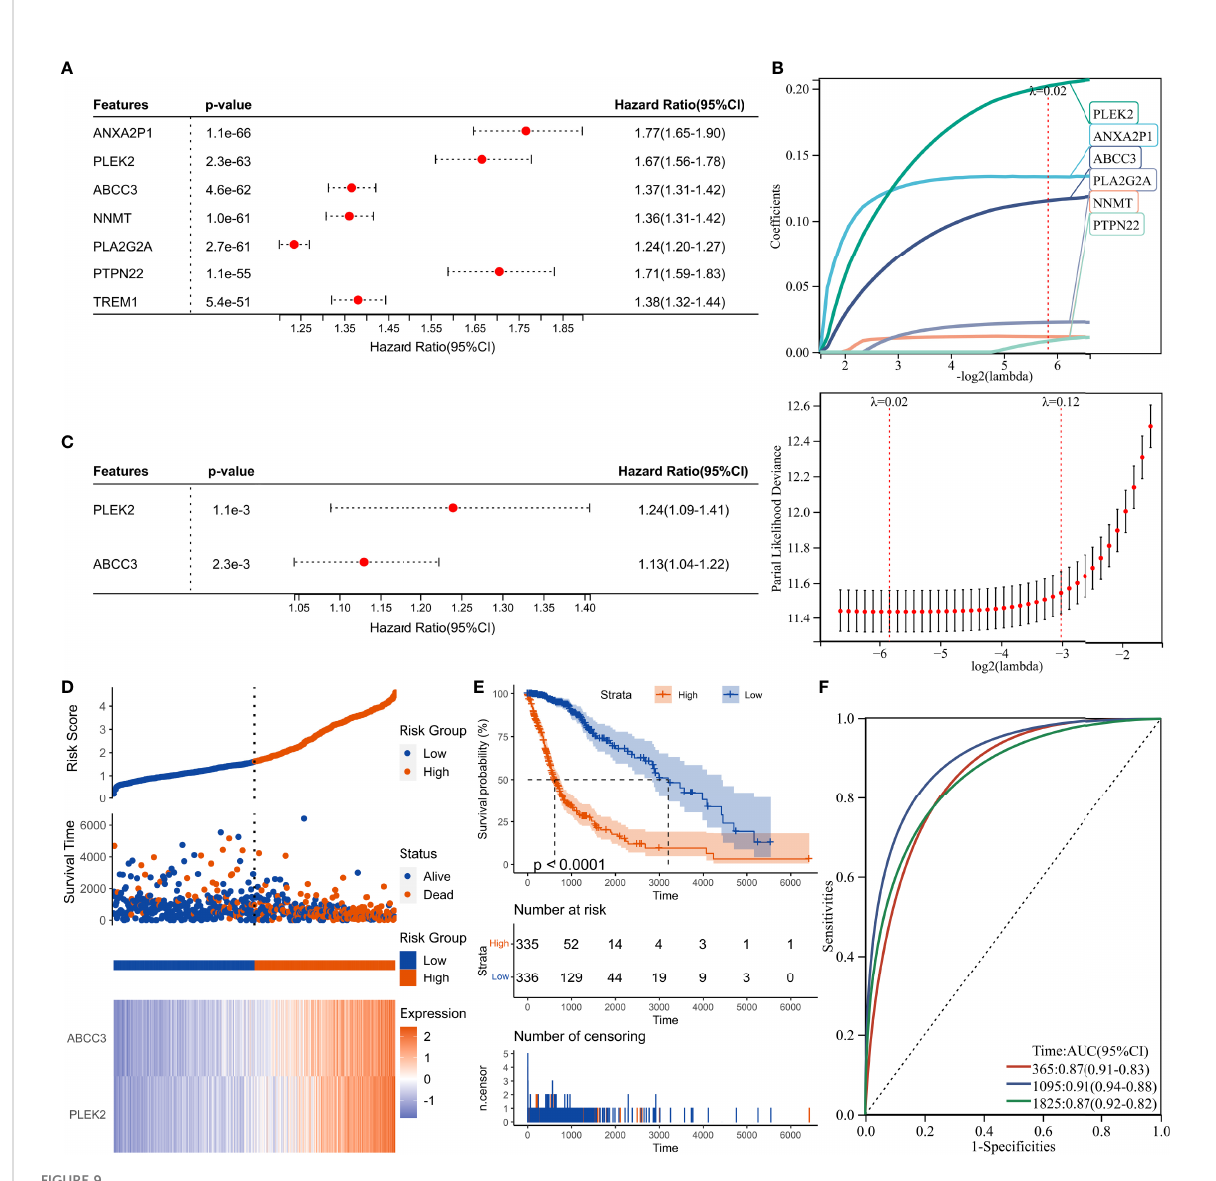
FIGURE 9 Construction of risk score signature. (A) Univariate Cox regression analysis of hub genes in the TCGA cohort. (B) LASSO Cox regression analysis of hub genes in the TCGA cohort. (C) Multivariate Cox regression analysis of hub genes in the TCGA cohort. (D) Distribution of the risk score, survival status, and expression pro fi le of the prognostic genes in the TCGA cohort. (E) Kaplan-Meier curves displaying prognostic differences between high- and low-risk groups in the TCGA cohort. (F) The ROC curves describing the sensitivity and speci fi city of risk score in predicting OS at 1-, 3- and 5-year time points in the TCGA